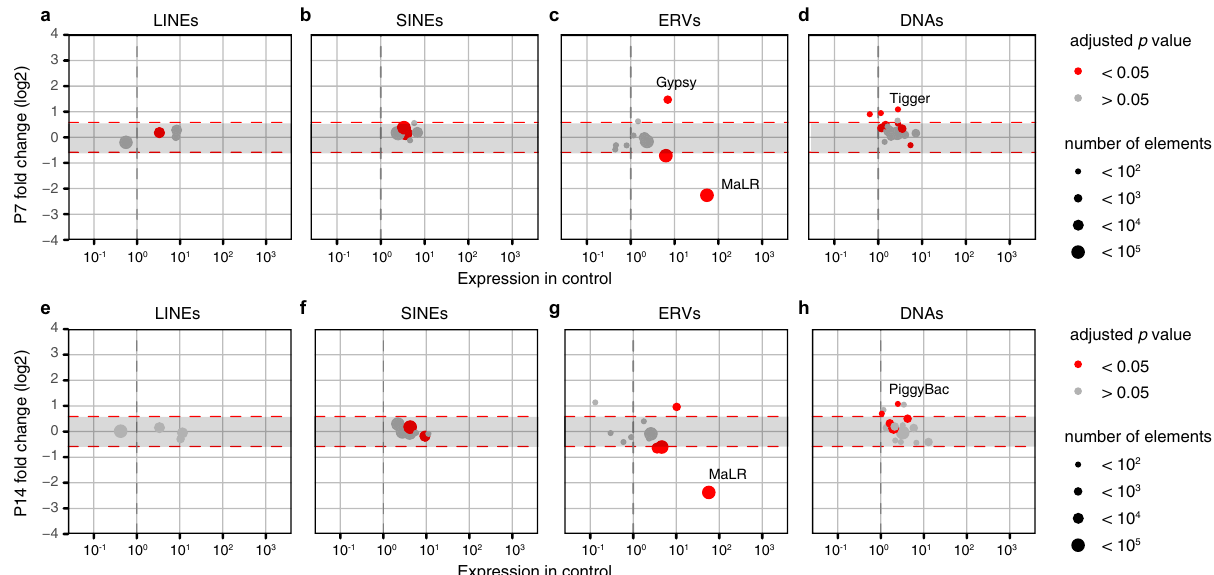
Fig. 4 Expression of the mammalian apparent LTR retrotransposons (MaLR) endogenous retroviral elements (ERV) are downregulated in growing Tbpl2 − / − mutant oocytes. a – h Differential expression between wild-type and Tbpl2 − / − mutant postnatal day (P) 7 ( a – d ) and P14 ( e – h ) oocytes of the different transposon classes; RNA transposon classes [LINEs ( a , e ), SINEs ( b , f ) and ERVs ( c , g )] and DNA transposons (DNAs ( d , h )). The ERV sub-class III mammalian apparent LTR retrotransposon (MaLR) family is the most severely affected in Tbpl2 − / − mutant oocytes at P7 and P14. Dot size and colour are explained on the right side, adjusted P value after two-sided Wald test and Benjamini – Hochberg correction for multiple